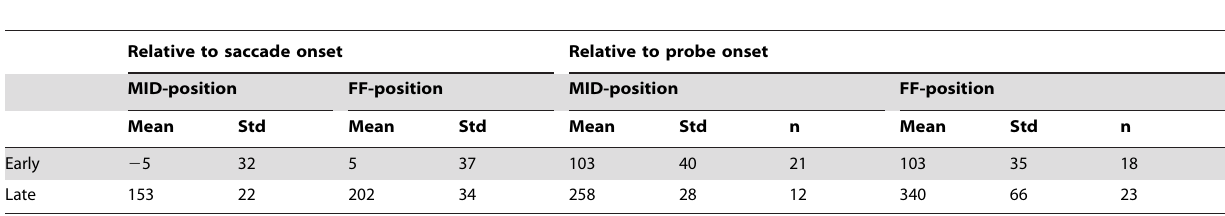
Table 1. Distribution of latencies (in ms) for early and late extraclassical responses to probes presented at MID and FF positions relative to the onset of the probe and relative to the